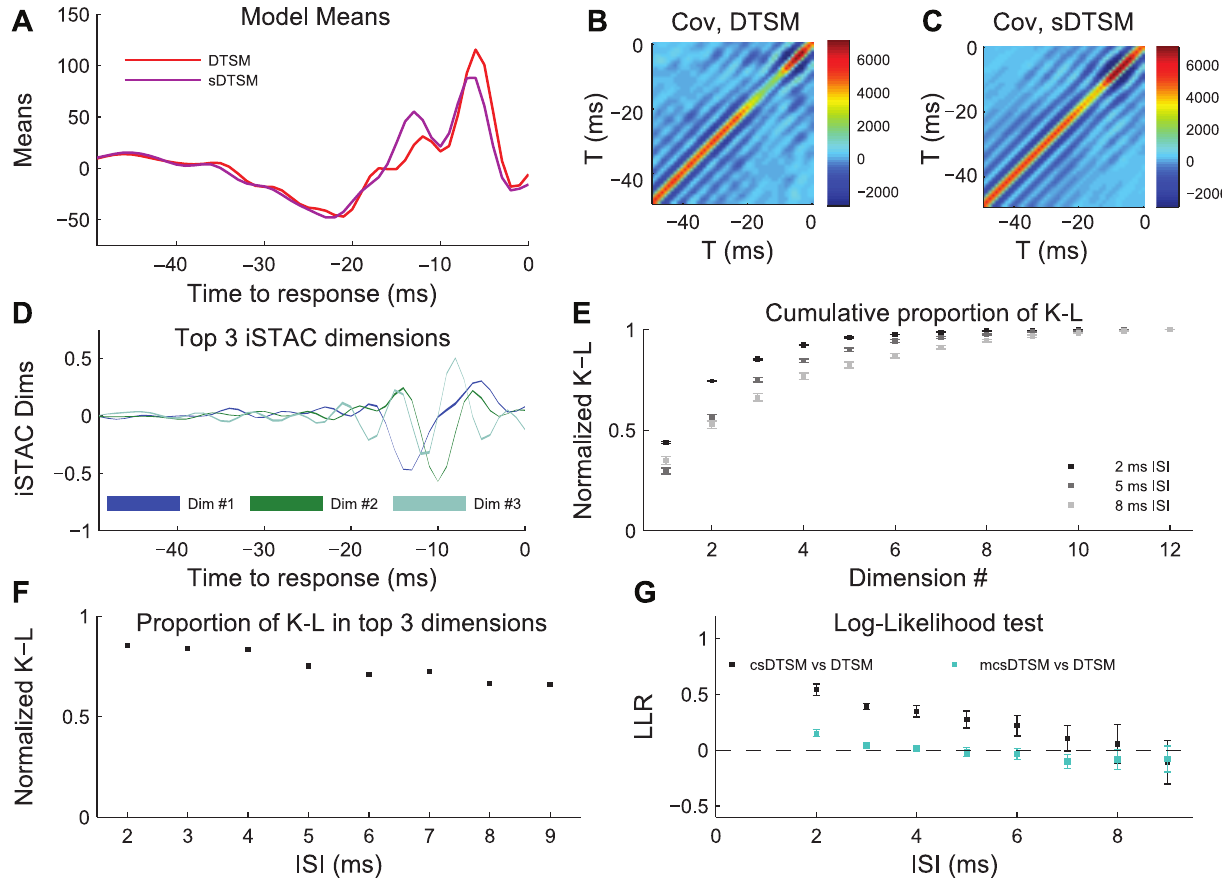
Figure 9. iSTAC analysis of data-based and synthetic models. A: Mean of data-based (red) and synthetic (purple) multivariate Gaussian models for stimulus preceding a 2 ms doublet, from the same cell as in Figures 7A and 7B. Covariance of data-based and synthetic models are shown in panels B and C, respectively (color scale in mm 2 /sec 2 ). D: Estimate of the 3 most informative iSTAC dimensions (shaded area indicates mean 6 SD across 10 6 validation). E: Measure of the total normalized K-L divergence between data-based and synthetic models for 2, 5, and 8 ms, as a function of subspace dimensionality. Mean 6 SD across 10 6 validation is shown with error bars, which are on the order of the size of the markers for the points. F: Measure of the portion of the total K-L divergence explained by the subspace containing the three largest iSTAC vectors, as a function of ISI in the model. G: Improvement of the synthetic model performance in LLR tests from the single cell in Figure 7B (black markers) by modification along the 3-dimensional subspace shown in panel 9D (cyan markers). Error bars represent 6 95% CIs on the